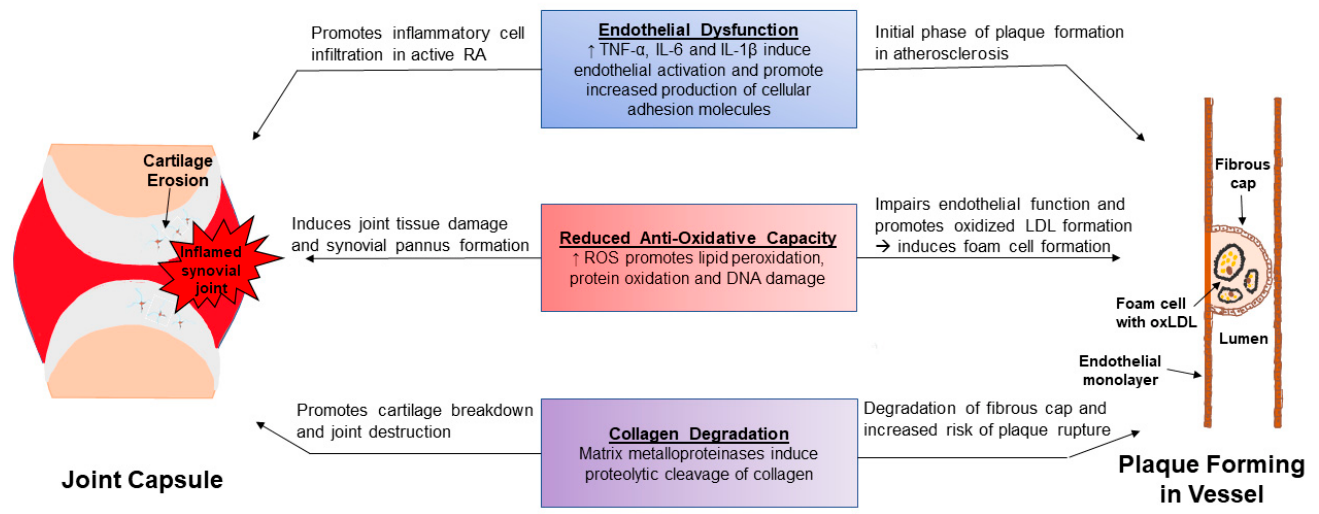
Figure 2. Shared inflammatory pathways are fundamental in the development of rheumatoid syn- ovitis and ASCVD. The initial phase involves endothelial dysfunction which promotes inflamma- tory cell infiltration within the joint capsule and the inception of plaque formation within the sub- intima of arteries. The reduction in anti-oxidative capacity in RA patients not only accelerates joint tissue damage, but also promotes LDL oxidation and foam cell formation. Increased matrix metal- loproteases (MMPs) evident in RA plasma then stimulates cartilage degradation in the joint and initiate deterioration of the fibrous cap surrounding the atherosclerotic plaque. This encourages plaque instability and eventual rupture which can lead to acute myocardial infarctions and strokes, depending on vessel location.